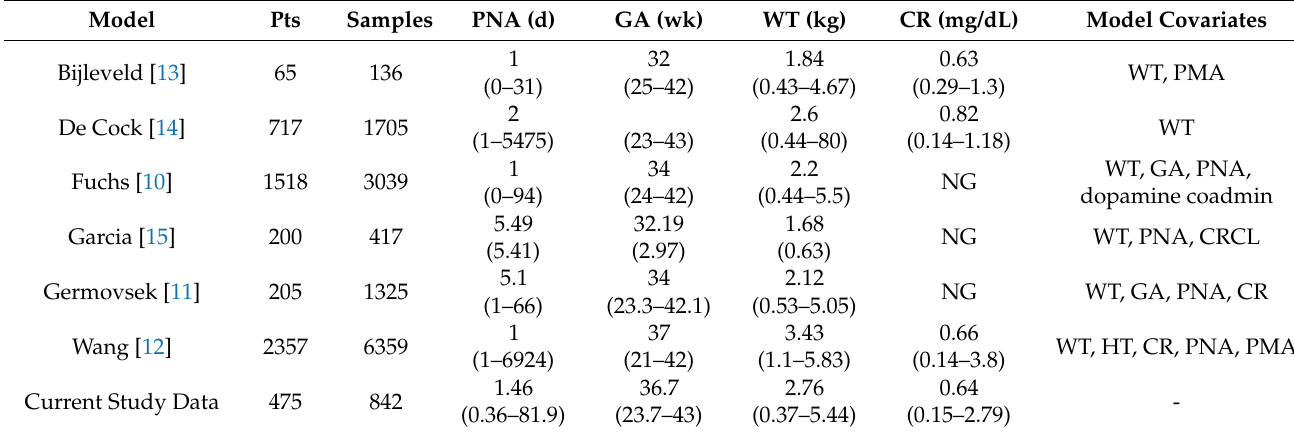
Table 2. The literature models describing neonatal gentamicin pharmacokinetics selected for evalua- tion and collected data covariates. Current study data covariates are also described. Values are given as counts (for patients, samples), median (range) or mean (standard deviation). PNA postnatal age; GA gestational age; PMA postmenstrual age; WT current weight; HT height; CR serum